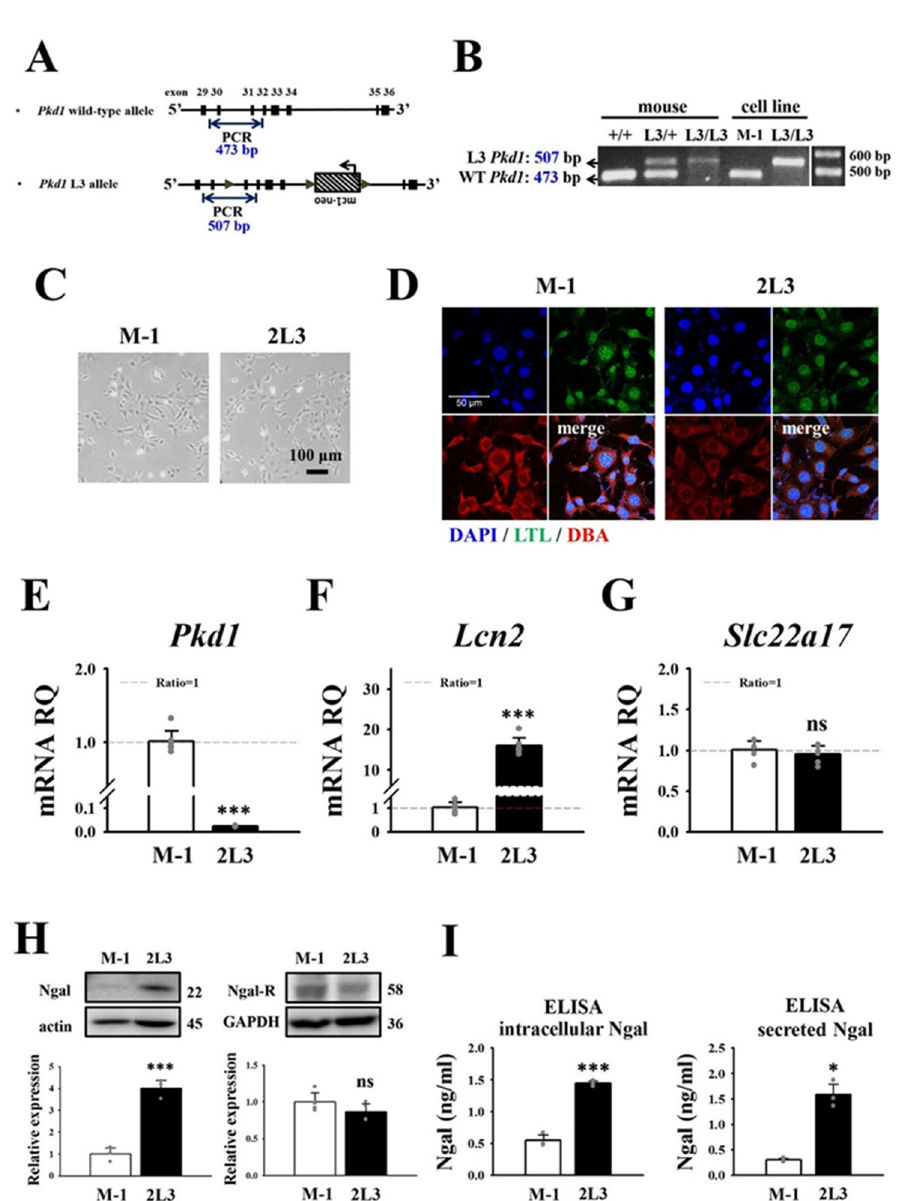
Figure 1. Comparison of NGAL expression between M-1 wild type and 2L3 ADPKD cells. ( A ) Struc- ture of wild type and L3 alleles of Pkd1 gene. PCR genotyping was conducted using primers before and after the first loxP within the intron 30 of Pkd1. Filled triangles: loxP; an mc1 promoter-driven neomycin resistance gene (mc1-neo) flanked by two loxP sites was inserted into intron 34 of Pkd1. ( B ) PCR genotyping of Pkd1 transcripts of M-1 cells (473 bp) and 2L3 cells (507 bp). Pkd1 transcripts of the wild type (+/+), heterozygous (L3/+), and homozygous (L3/L3) mice were used as the control. RT–qPCR showed that 2L3 had significantly lower Pkd1 ( C ) M-1 and 2L3 cells show similar mor- phology. Scale bar: 100 µm. ( D ) M-1 and 2L3 cells were stained with Lotus Tetragonolobus Lectin (LTL, labeled with Fluorescein, green) and Dolichos biflorus agglutinin (DBA, labeled with Rhoda- mine, red) and DAPI (blue) and observed by a confocal microscope. Scale bar: 50 µm. RT–qPCR showed that 2L3 had significantly lower Pkd1 ( E ) and higher Lcn2 (NGAL) ( F ) expression levels than that of M-1 wild type cells. ( G ) No significant difference in Slc22a17 (NGAL-R) expression levels between M-1 and 2L3 cells. RQ: relative quantification = 2 −ΔΔ Ct ; Gapdh was used as the internal control of each sample. Values were normalized to M-1. ( H ) Western blot results showed that 2L3 cells had significantly higher expression of NGAL but not of NGAL-R than M-1 cells. Actin and GAPDH were used as the internal controls of each sample. Values were normalized to the control group of 2L3. ( I ) ELISA showed that 2L3 had higher expression of NGAL compared with M-1 in